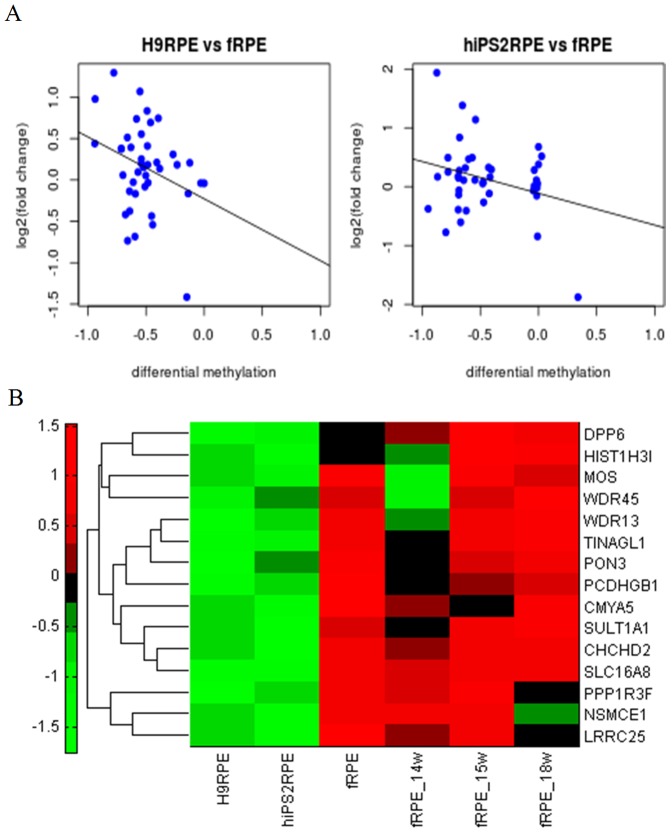
The correlation of gene expression and DNA methylation in hESC-/hiPSC-RPEs and fRPEs.(A) Scatterplots of gene expression fold change vs DNA methylation change in hESC- and hiPSC- RPEs vs. fRPEs. The correlation coefficients were −0.306 (p-value = 0.051) and −0.288 (p-value = 0.067), respectively. (B) Gene expression heatmap analysis of selected genes that are methylated in H9 ESC-RPE, but not in fetal RPE.